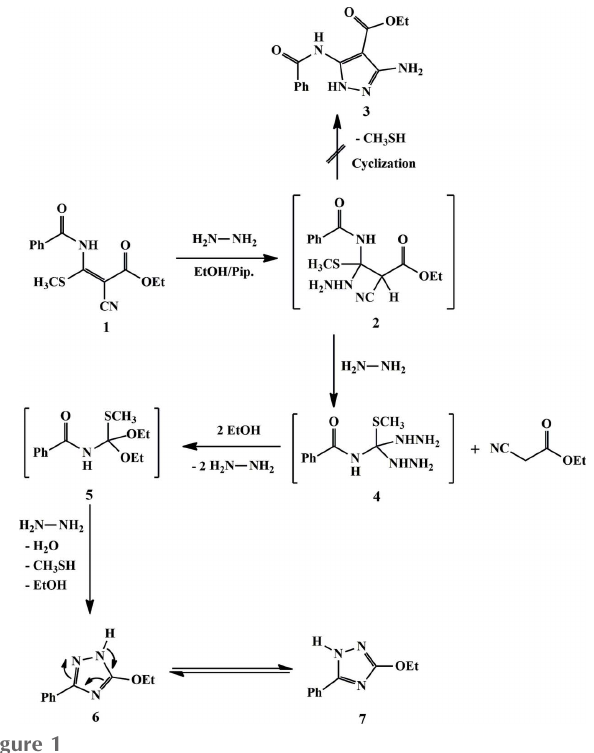
Figure 1 Reaction